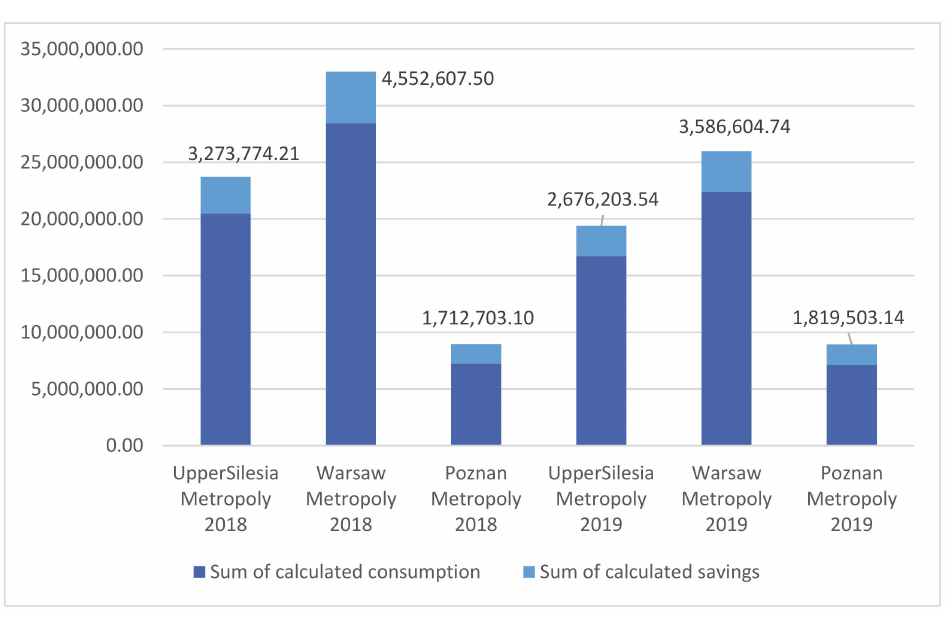
Figure 4. The results of a simulation of the installation of the Hubgrade system in all the district heating systems in the GZM, Pozna´n and Warsaw Metropolises (GJ). Own elaboration based on data from HUBGRADE in Warsaw and data on the emissions in GZM and